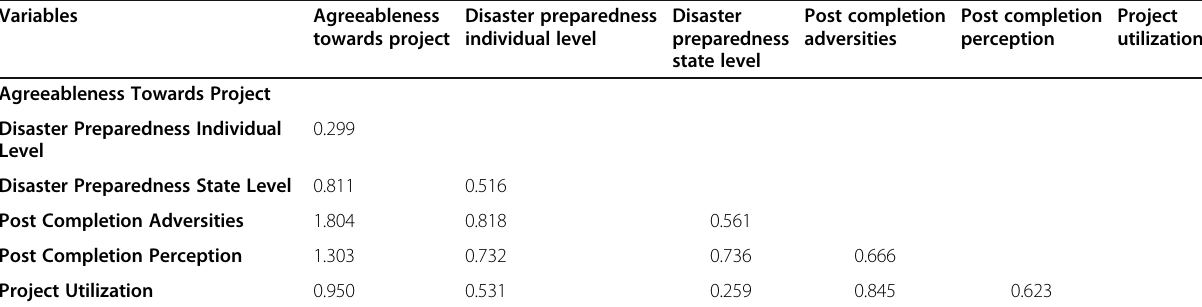
Table 7 Instrument ’ s discriminant validity (Heterotrait-Monotrait Ratio)